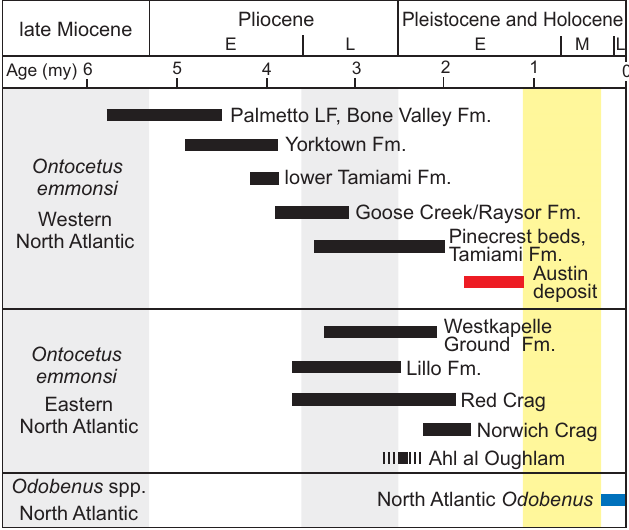
Fig. 4. Biochronology of the walruses Ontocetus and Odobenus in the North Atlantic basin. Yellow vertical bar denotes temporal gap between the last occurrence of Ontocetus and the first occurrence of Odobenus in the North Atlantic. See SOM 1, 2 (Supplementary Online Material available at http:// app.pan.pl/SOM/app63-Boessenecker_etal_SOM.pdf) for discussion of the geochronologic age of each occurrence. Abbreviations: E, early; L, late; M,